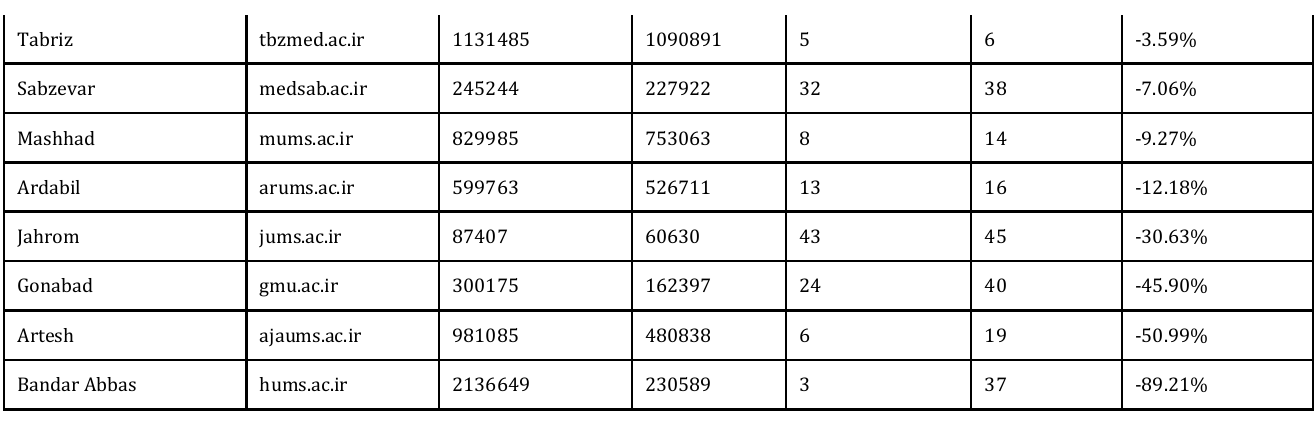
Table 2 shows the growth of each of the Webometrics indicators such as page size, scientific resources indexed in Google Scholar, input links and rich files in the next half year 2016. According to the findings, highest grow is related to the index of page size with 226.35%, the index of scientific resources indexed in North Khorasan University of Medical Sciences with 723.90%, the index of links to the sites of Bushehr University of Medical Sciences with 197.28%, and the rich files indexed by the University of Medical Sciences with the rate of %483.11.